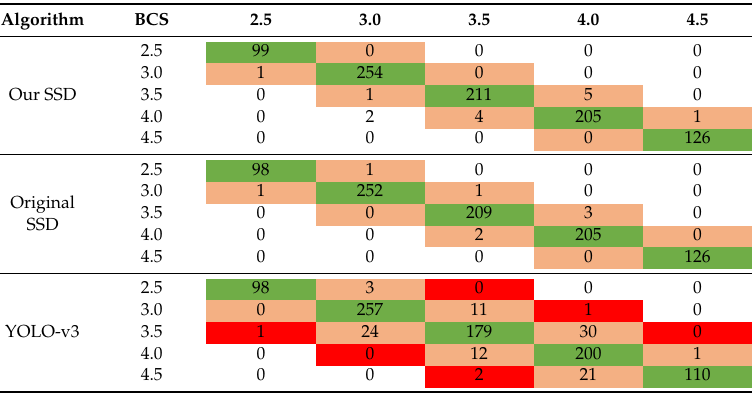
Table 5. Confusion matrices of test samples classification for three algorithms. Green cells represent exact predictions, orange cell represent predictions with 0.5 units of error, and red cells represent predictions with 1.0 units of